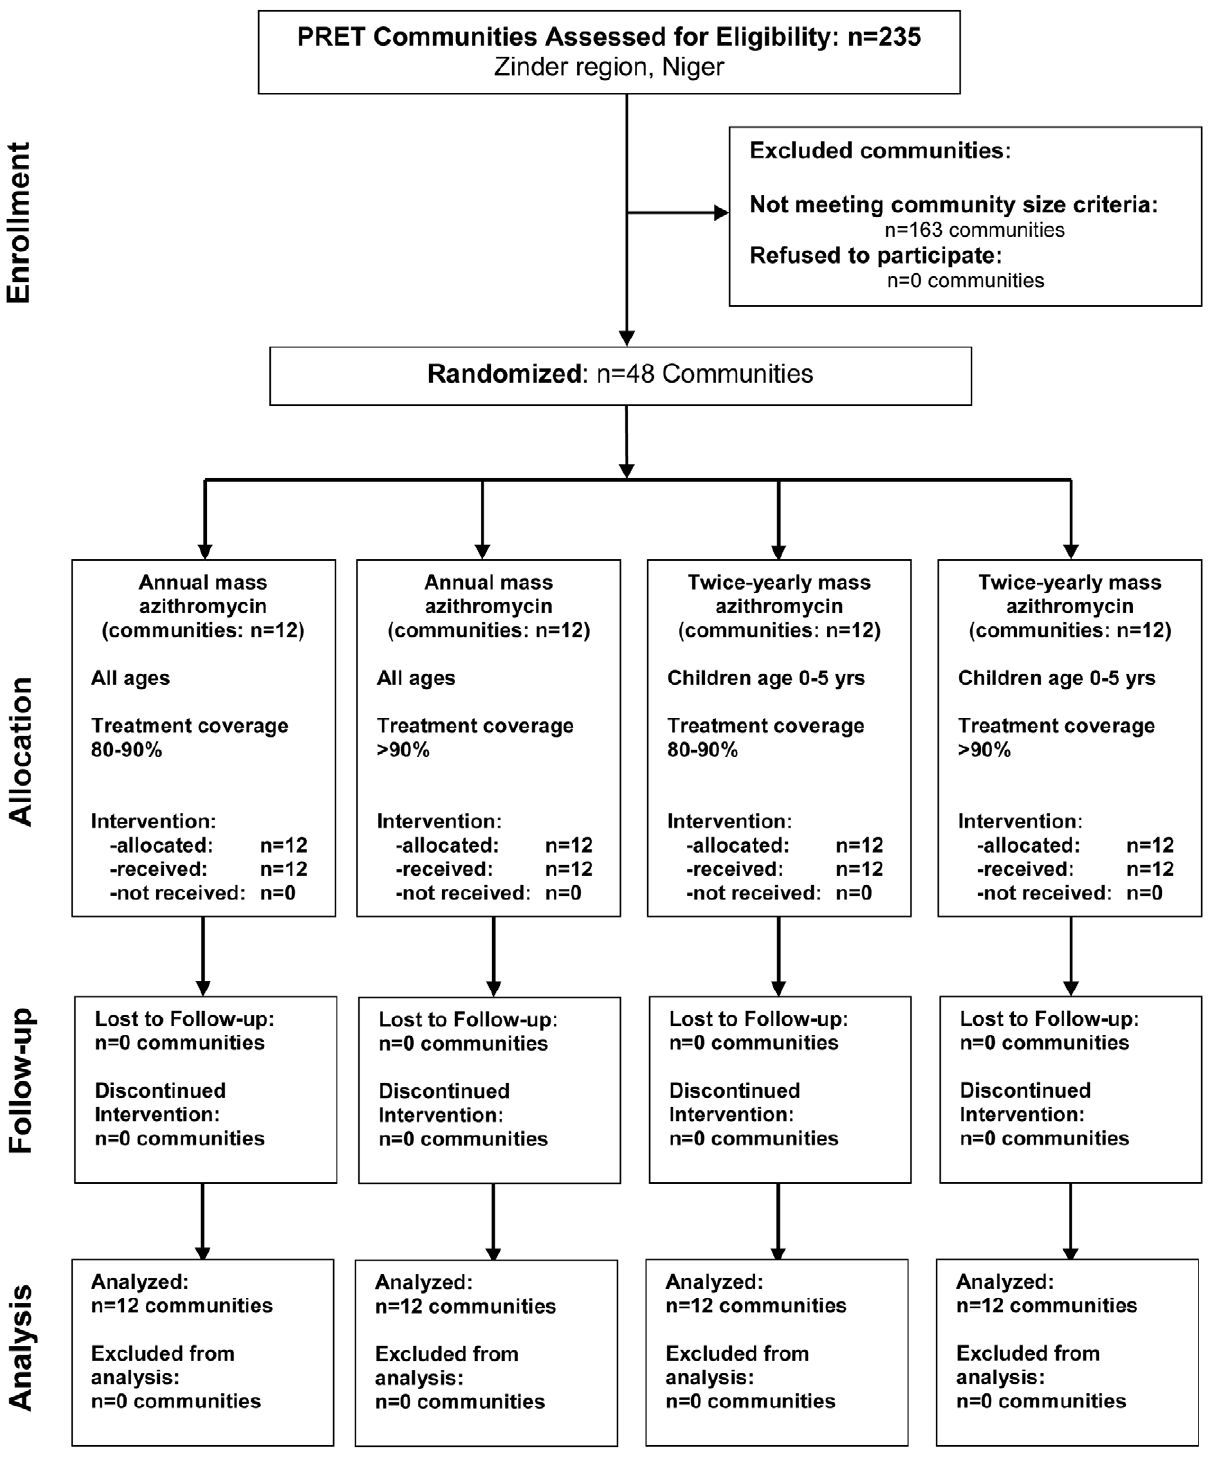
Figure 1. Consort flow diagram: cluster-randomized trachoma trial in Niger.